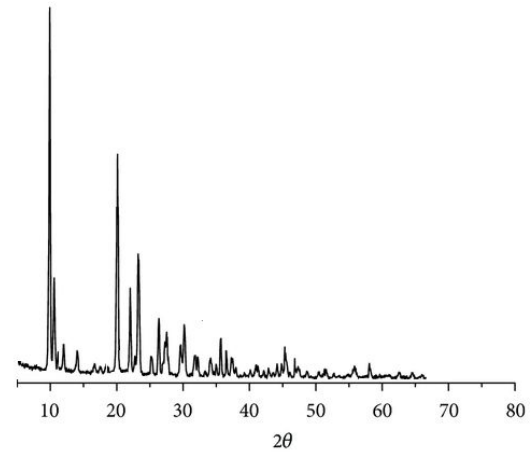
Figure 5. Powder X-ray diffraction of the CoHo:PGLyD microspheres.